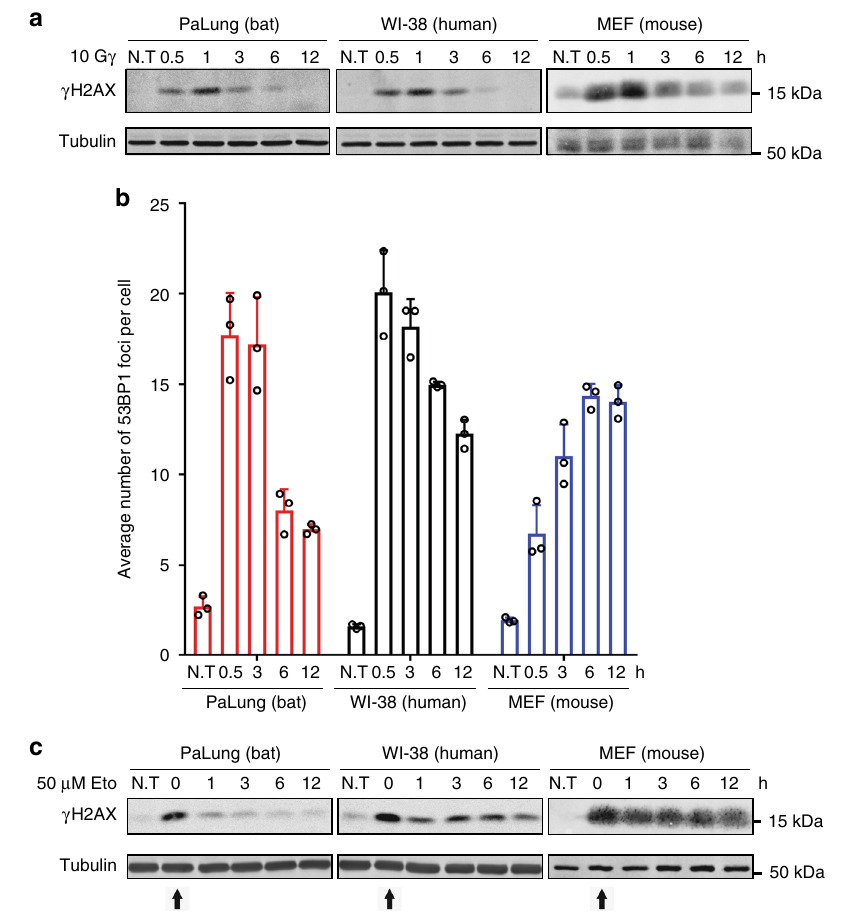
Fig. 1 γ H2AX and 53BP1 responses to γ -irradiation and etoposide in bat, human and mouse cells. a Western blot analysis of γ H2AX in PaLung, WI-38 and MEF cells exposed to 10 Gy of γ -irradiation. Protein lysates were harvested at the indicated time points. Tubulin was used as a loading control. b Analysis of the average number of 53BP1 foci per cell for PaLung, WI-38 and MEF cells treated with 10 Gy of γ -irradiation. Immuno fl uorescence staining of 53BP1 was performed at the indicated time points. The number of foci in a minimum of 100 cells was quanti fi ed. Bars represent the means ± SDs of three independent experiments. c Western blot analysis of γ H2AX in PaLung, WI-38 and MEF cells treated with 50 μ M etoposide (Eto) for 3 h, followed by drug-free medium up to 12 h (starting at t = 0 h, indicated by arrow). Protein lysates were harvested at the indicated time points. Tubulin was used as a loading control. N.T stands for no treatment. All Western blot results shown are representative of at least three experimental